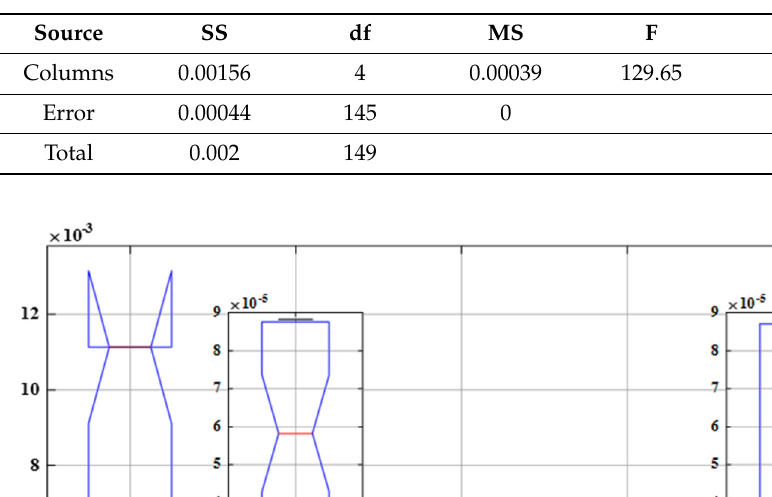
Table 6. ANOVA results for